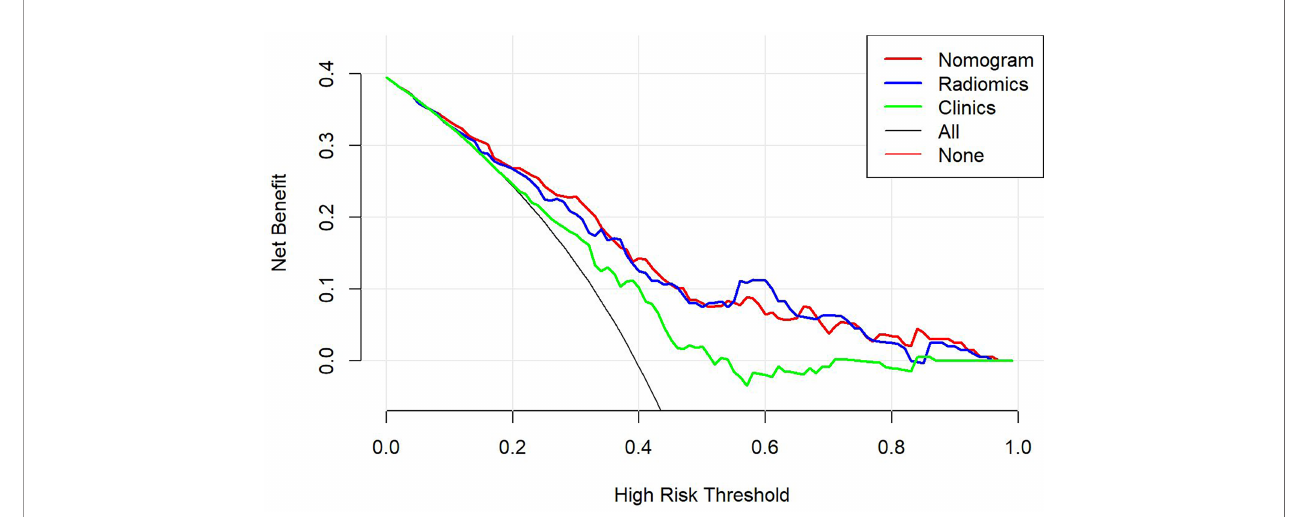
FIGURE 8 | The decision-making curves of the radiomics, clinical radiomics, and clinical models based on the T2-weighted imaging (T2WI) sequence, where the X- and Y-axes represent the threshold probability and net bene fi t, respectively. Red indicates the clinical radiomics model, blue stands for the radiomics model, and green represents the clinical model. The Y-axis represents the 0-parallel line, indicating that all samples were negative (assuming that all patients were in the non- response group after treatment). The black line is based on the assumption that all samples were in the response group after treatment, and the net bene fi t is represented by the diagonal line with a negative slope. The net bene fi t is the proportion calculated by subtracting the false positive count from the true positive count. The threshold probability (Pt) was within the range of 0.1 – 0.8. The radiomics and clinical radiomics nomograms had a higher Pt and corresponding net bene fi ts than the clinical model, revealing that a higher clinical net bene fi t was obtained in predicting the therapeutic effect of neoadjuvant